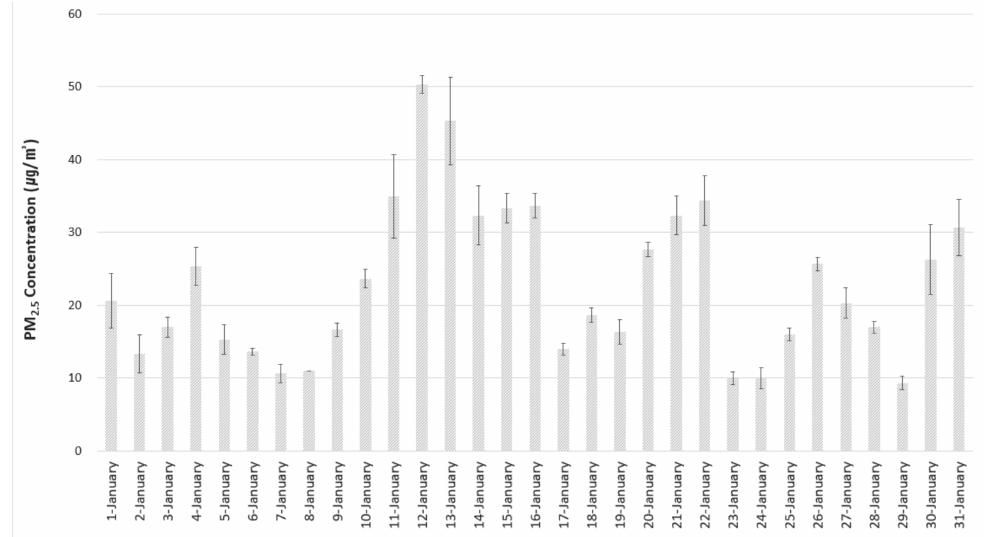
Figure 9. Standard deviation analysis results of PM 2.5 concentrations in three regions in January 2021 [44–46].